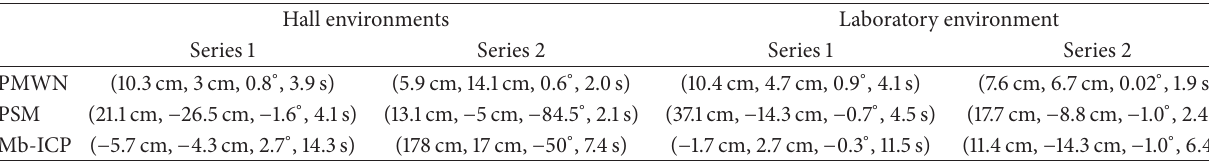
Table 4: Loop closure errors of maps and runtime.